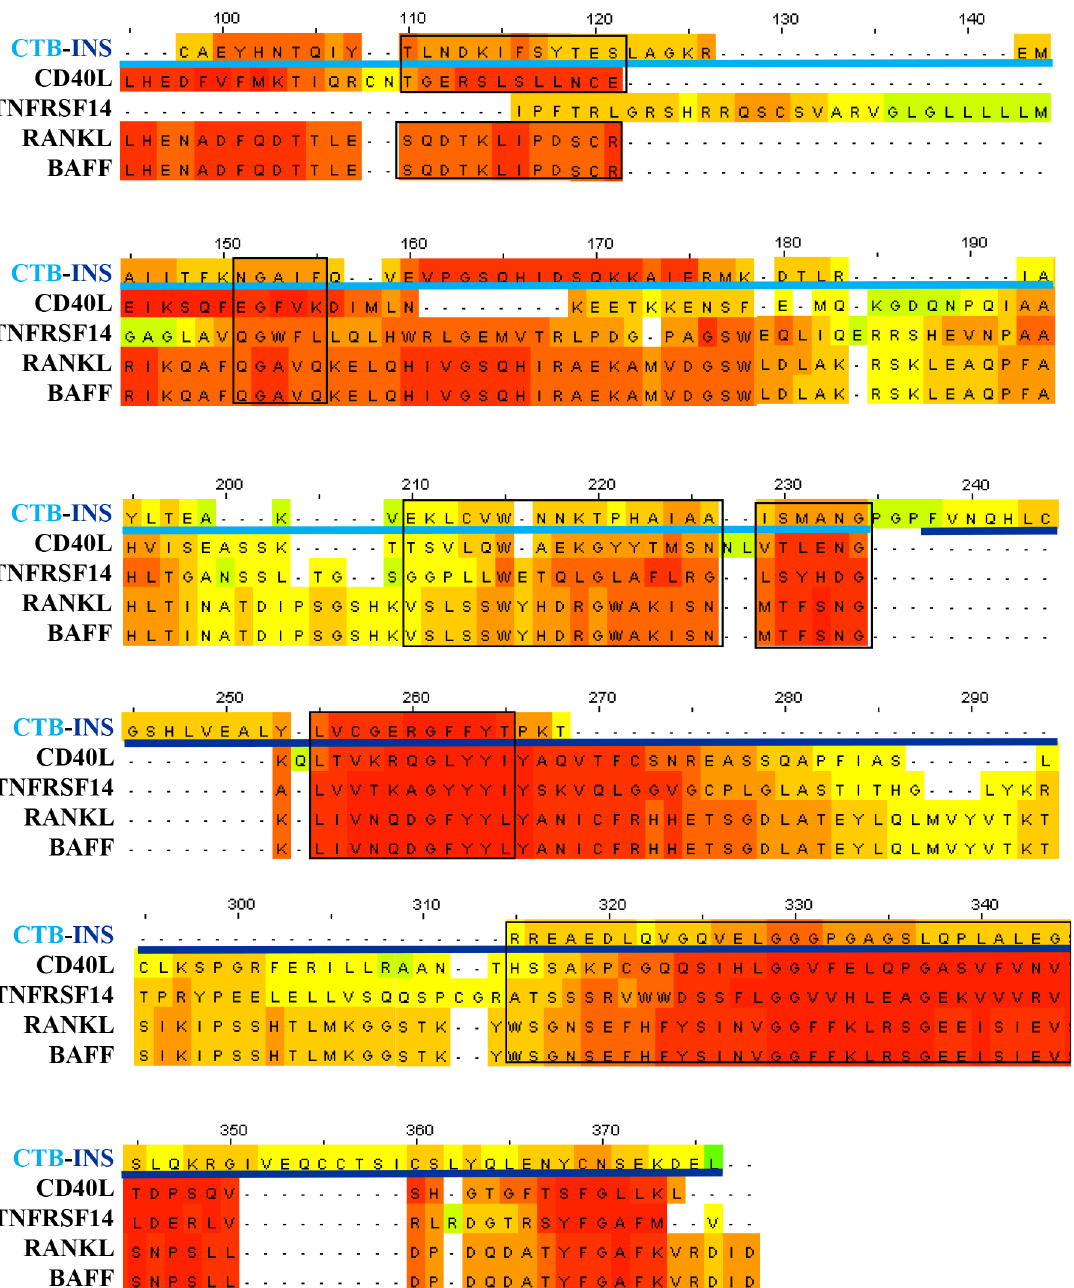
Fig 7. Comparison of the amino acid sequence of CTB-INS with ligands of the Tumor Necrosis Factor Receptor (TNFR) superfamily (CD40L, TNF14, RANKL and BAFF). The light-blue horizontal line corresponds to the amino acid sequence of CTB and the dark-blue horizontal line denotes the amino acid sequence of proinsulin. The black boxes highlight areas of greater functional binding homology among TNFR family members, in which the red highlighted areas signify greater levels of amino acid homology and the green areas, low to no detectable